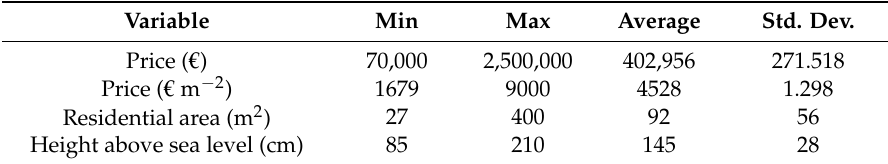
Table 1. Summary of cardinal variables of the sample.